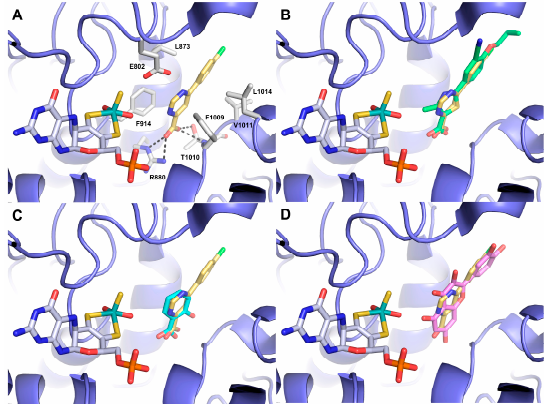
Figure 5. Predicted binding mode of compound ALS-28 (( A ), yellow sticks) into XO (slate ribbons, PDB 1N5X). Only amino acids discussed in the main text are displayed (white sticks) and labelled. H-bonds discussed in the text are depicted as dashed black lines. Overlay of ALS-28 docked pose on febuxostat (( B ), green sticks, PDB 1N5X), salicylic acid (( C ), cyan sticks, PDB 1FIQ) and quercetin (( D ), violet sticks, PDB 3NVY) co-crystallised into XO.